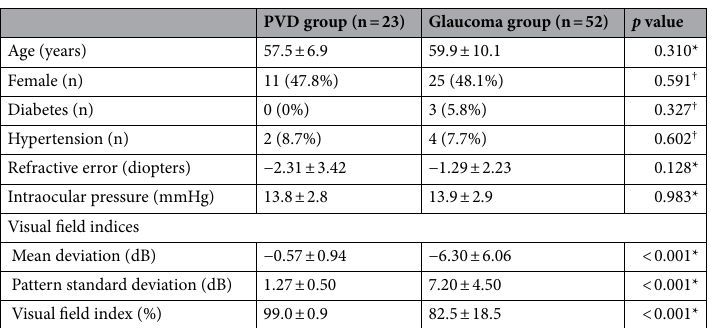
Table 1. Clinical characteristics of eyes with posterior vitreous detachment-related optic disc hemorrhage (PVD group) and glaucomatous optic disc hemorrhage (glaucoma group). PVD posterior vitreous detachment. *Independent t-test. † Fisher’s exact test.